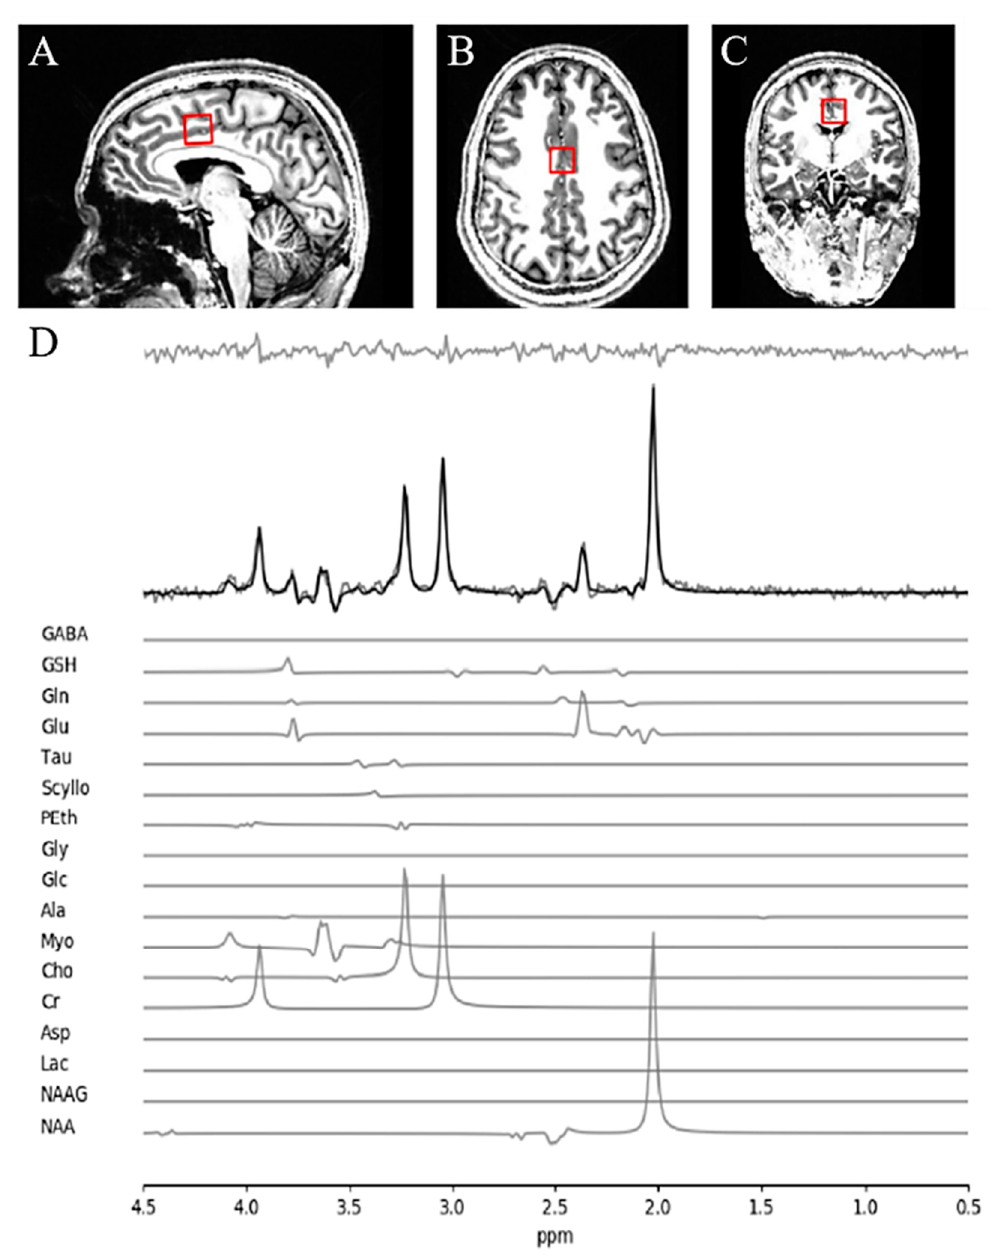
Figure 1. MRS voxel and spectra. ( A ) Sagittal, ( B ) axial, and ( C ) coronal view of voxel positioning on the dorsal anterior cingulate cortex (dACC). ( D ) Sample spectra obtained from a single healthy participant. The bold black line represents the fitted spectra with the residuals above (the gray line above the fitted curve) and each individual metabolite contribution below.